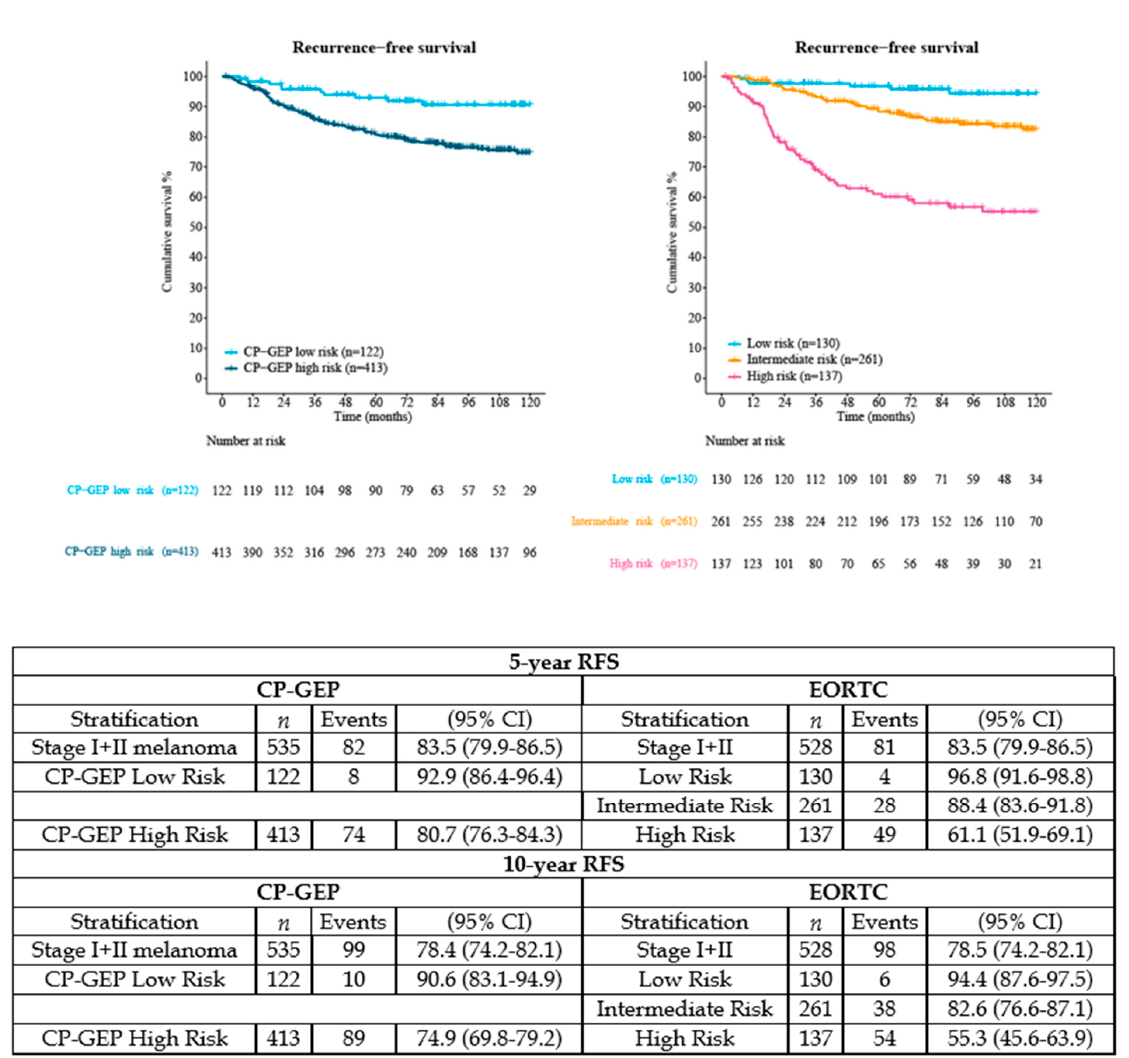
Figure 2. Comparison RFS between CP-GEP and EORTC nomogram in stage I–II melanoma. Because ulceration and/or anatomical site of the primary melanoma was unknown, 7 patients were excluded from the EORTC nomogram ( n = 528 instead of n = 535 included for CP-GEP). Abbreviations: CP-GEP, clinicopathologic and gene expression profile; EORTC, European Organization for Research and Treatment of Cancer; RFS, recurrence-free survival; SLNB, sentinel lymph node biopsy; 95% CI, 95% confidence